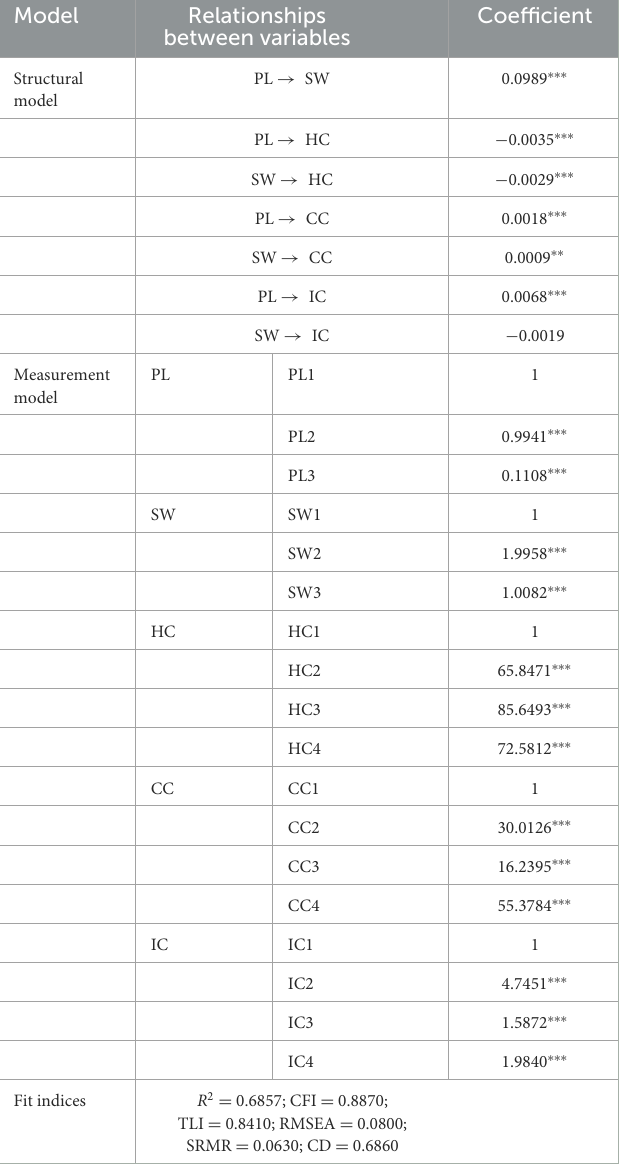
TABLE 3 Baseline regression results.